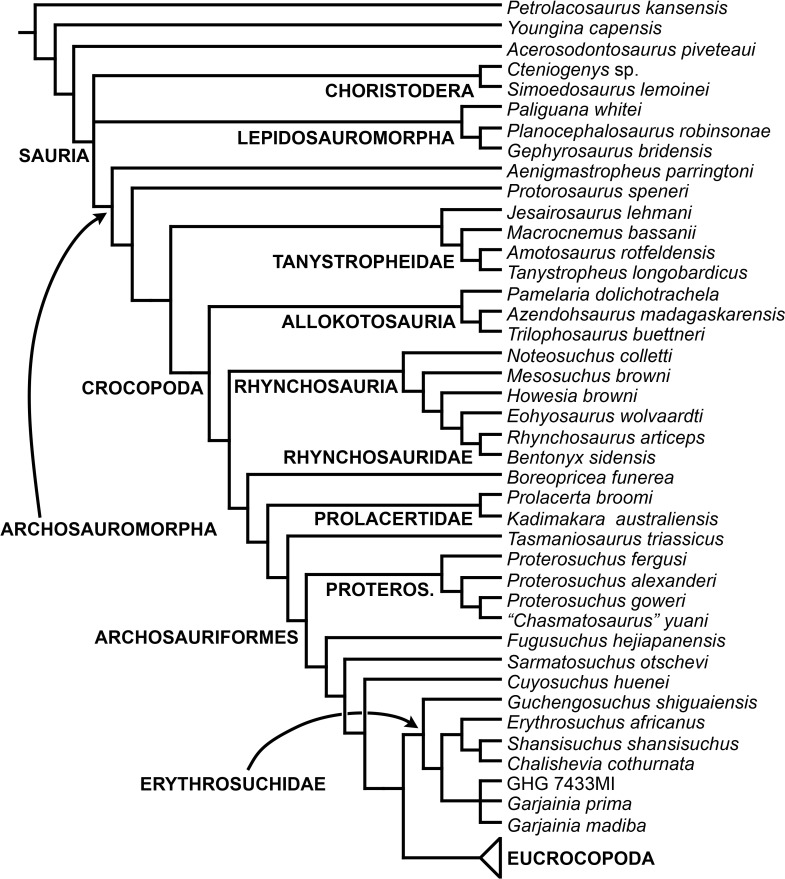
Strict reduced consensus tree recovered from analysis 3 showing the phylogenetic relationships of archosauromorphs after the a posteriori pruning of Kalisuchus rewanensis and  Asperoris mnyama.Eucrocopodans have been merged into a single terminal in this tree.